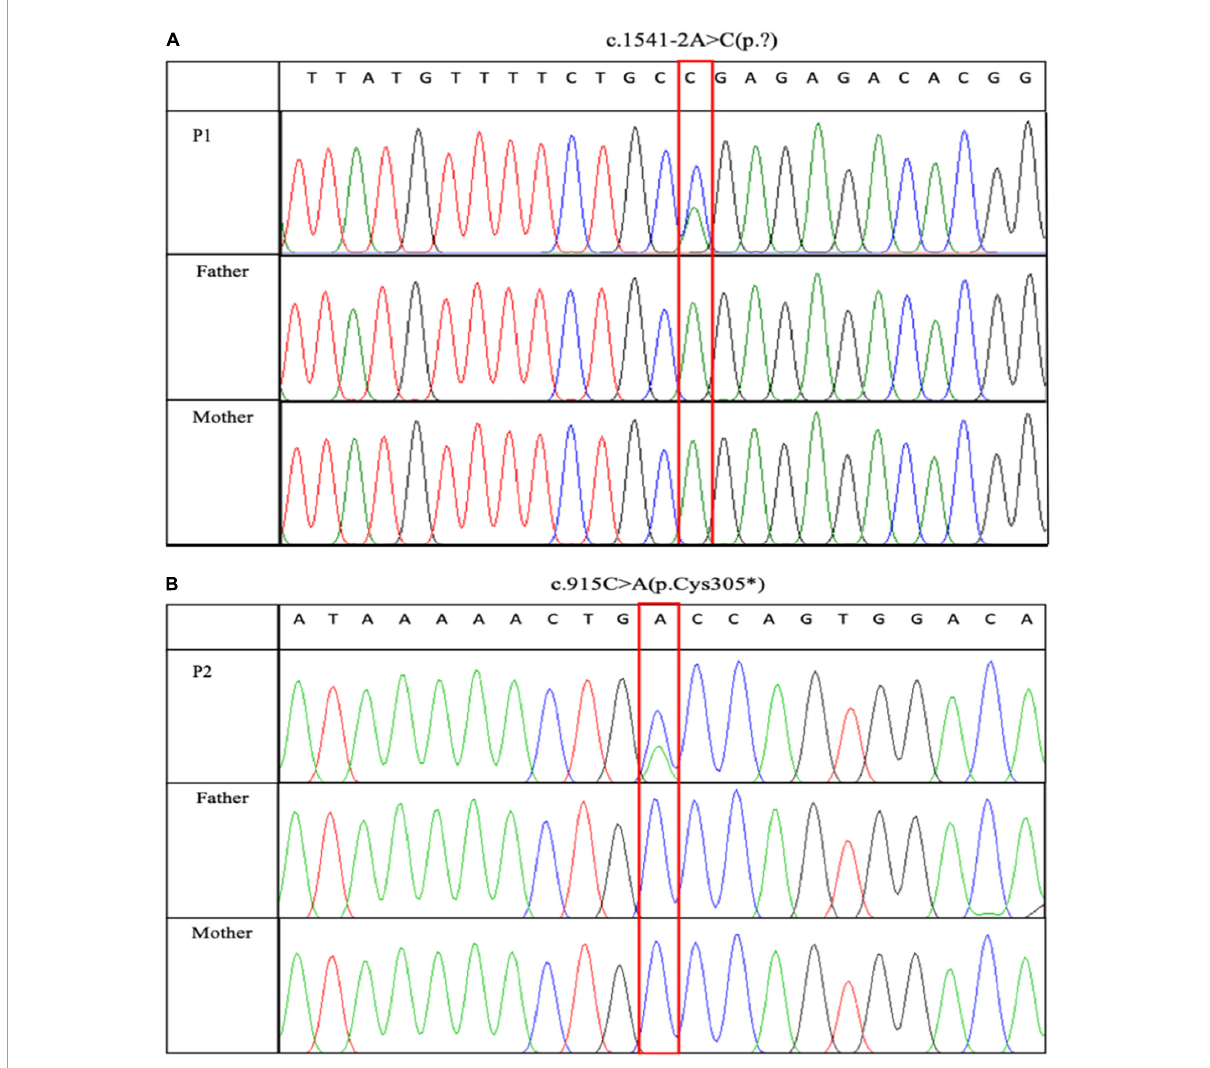
FIGURE1 Sanger sequencing maps of two pathogenic variants. c.1541-2A > C and c.915C > A were identified in P1 and P2, respectively. Sanger sequencing verified that the two variants occurred de novo . (A) c.1541-2A > C was identified in P1. (B) c.915C > A was identified in